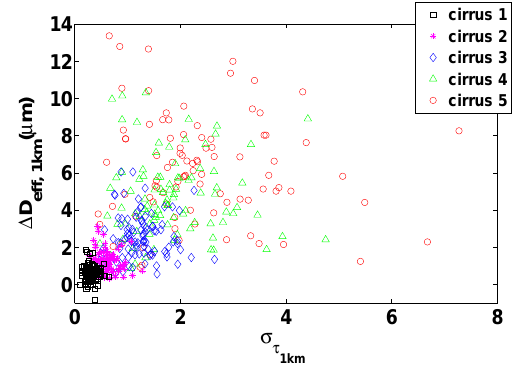
Figure 5. Errors on the effective emissivity (cid:49)ε eff ( a , b and c ) and on the effective optical thickness (cid:49)τ eff ( d , e and f ) at 8.65, 10.60 and 12.05µm, respectively, as a function of the optical thickness standard deviation, σ τ ( τ c = 0 . 90 , ρ τ = 0 . 7), 3 ( τ c = 1 . 80 , ρ τ = 0 . 7), 4 ( τ c = 1 . 80 , ρ τ = 1 . 1) and 5 ( τ c = 1 . 80 , ρ τ = 1 . 5) with D eff = 9 . 95µm for the five cirrus. The black lines correspond to the IIR operational algorithm uncertainty on the effective emissivity.